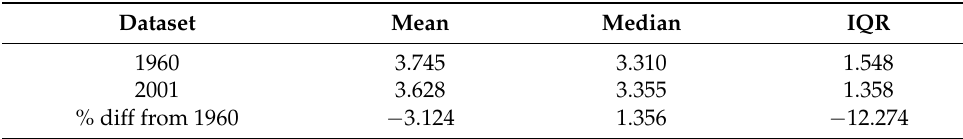
Table 11. Summary statistics of the rainfall data